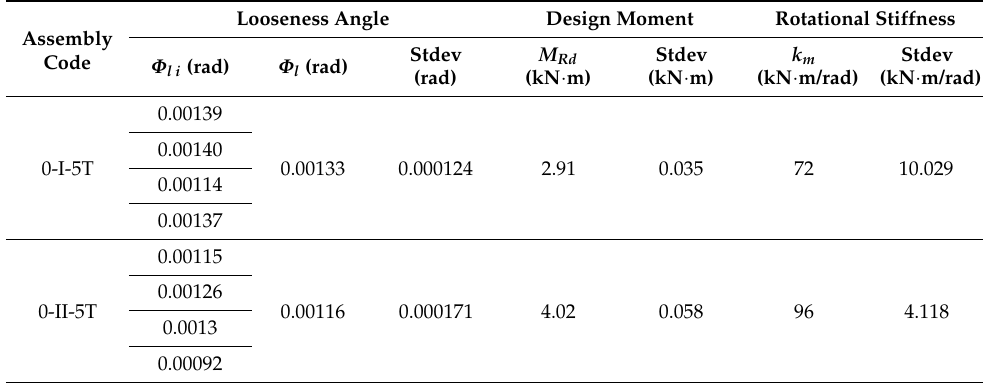
Table 3. Results obtained in looseness tests and bending tests for all assemblies involved in the experimental program.